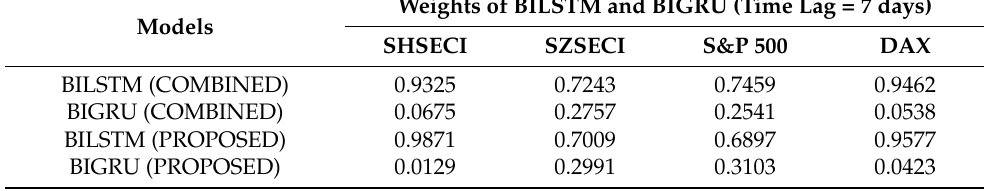
Table 5. Weights of BILSTM and BIGRU (time lag = 7 days).